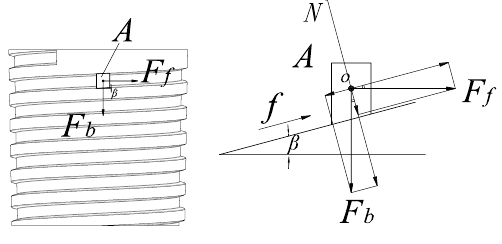
Figure 3. Force diagram of thread A